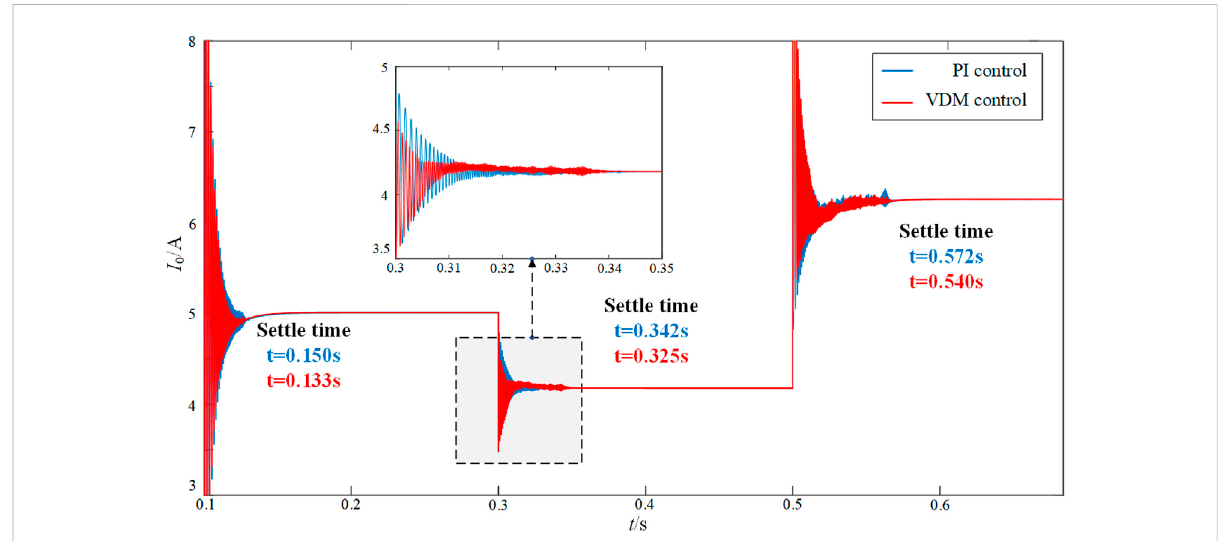
FIGURE 9 Comparison diagram of CPL current under CPL load step condition.